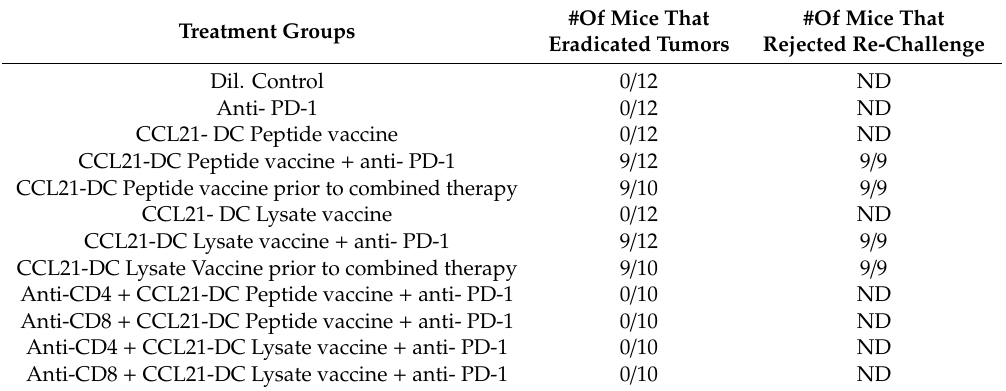
Figure 2A: There was enhanced CD8 T cell perforin expression following combined